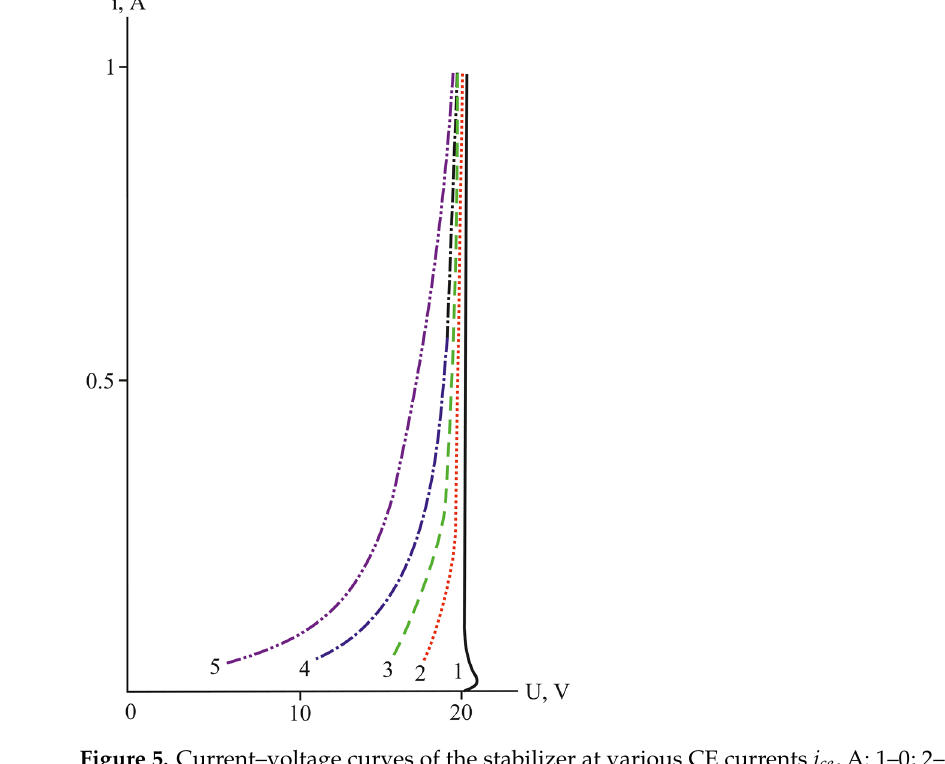
Figure 5. Current–voltage curves of the stabilizer at various CE currents i ce , A: 1–0; 2–0.02; 3–0.04; 4–0.06; 5–0.08; P He = 3 Torr.